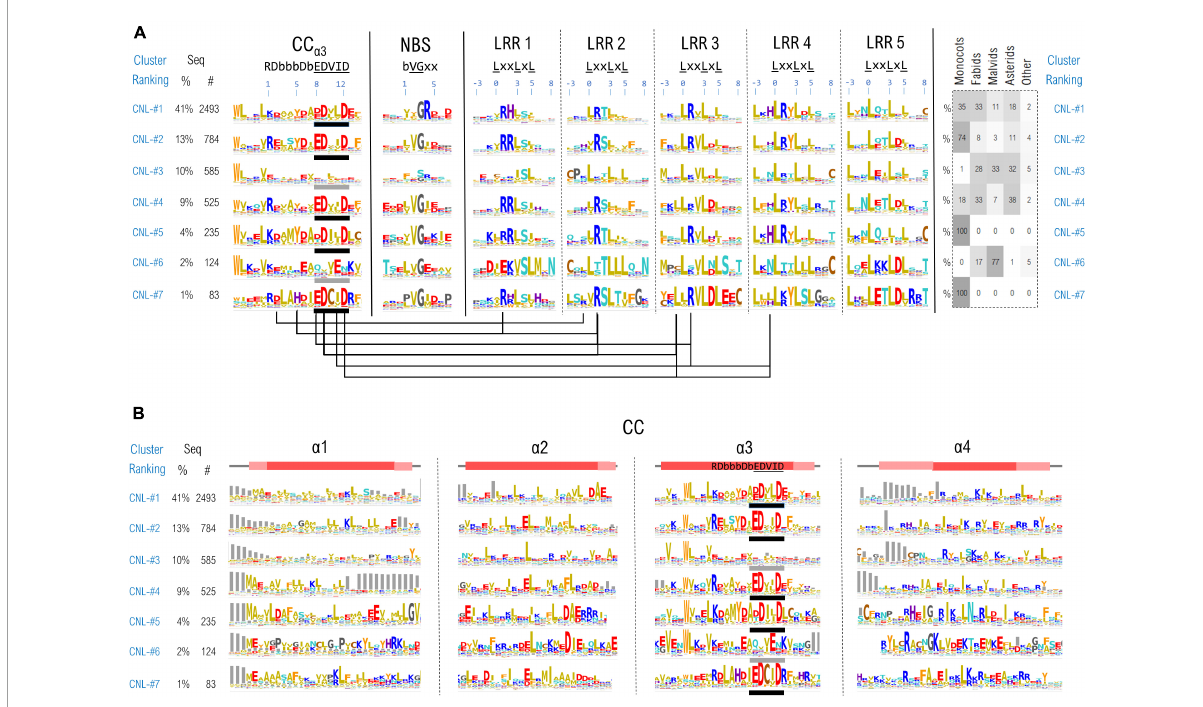
FIGURE7 (A) CNL proteins clustering based on the regions confining the CC extended EDVID ( α 3 helix) and the first 5 LRR motifs. Motif variability is expressed as relative entropy displayed as letter height (the higher the more conserved). The taxonomic distributions of each cluster is depicted in the right panel. The ZAR1 CC-LRR contacts within 5Å are mapped below the motif consensus (PDB: 6j5w). (B) Zoom in on the conservation profile of the CC domain of the top CNL clusters from (A)